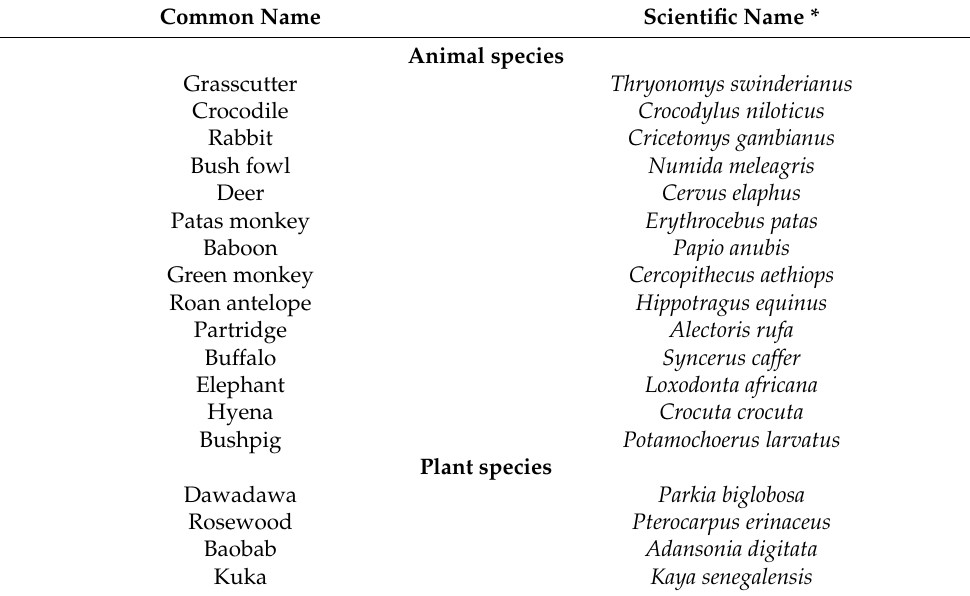
Table 2. The perceived scarcity of wild animal species and declining plant